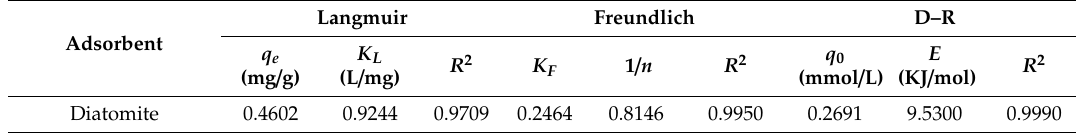
Table 4. Adsorption isotherm parameters of three kinds of diatomite onto